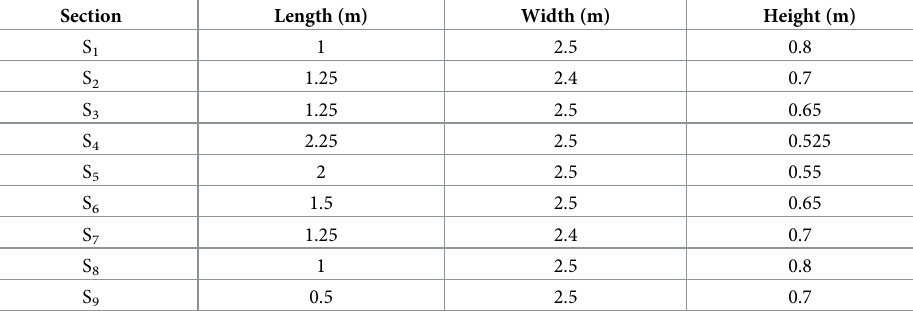
Table 10. Vehicle modeling—Bus.